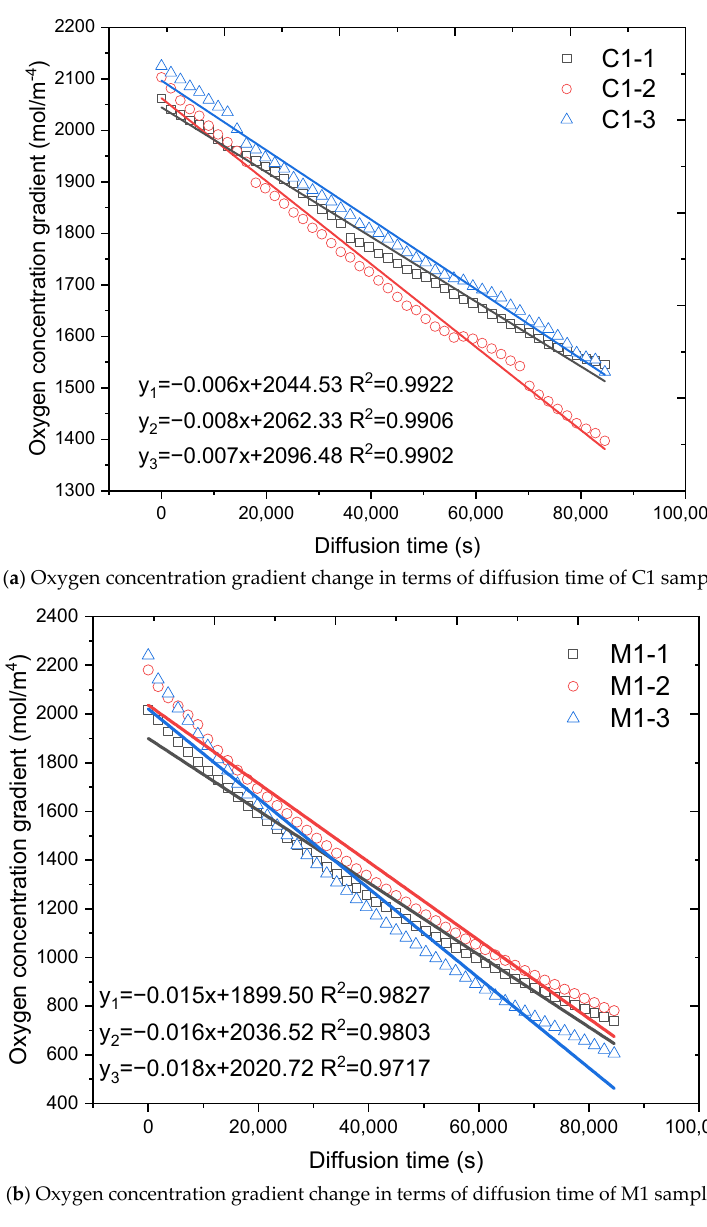
Figure 7. Typical Oxygen concentration gradient change in terms of diffusion time.